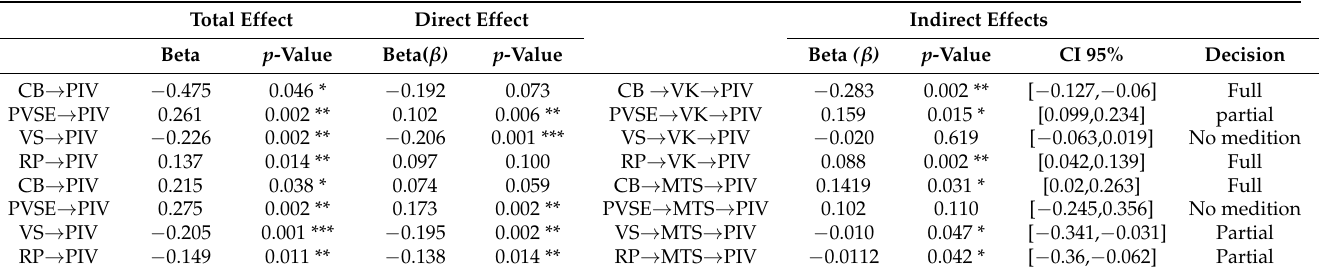
Figure 2. Diagram of structural model with standardized regression coefficients. Note: Straight line ( → ) represent direct relation, Dotted line (—-) represent mediation. Significance of Estimates. Safety (VS), Risk Perception (RP), Parental Vaccine Intention (PIV), Parental Vaccine Self- Efficacy (PVSE) and Mistrust in Science (MTS). Table 6. Total, direct and indirect effects of psychosocial factors, Vaccine Knowledge, Mistrust in science on parents’ Intention towards their kid’s COVID-19